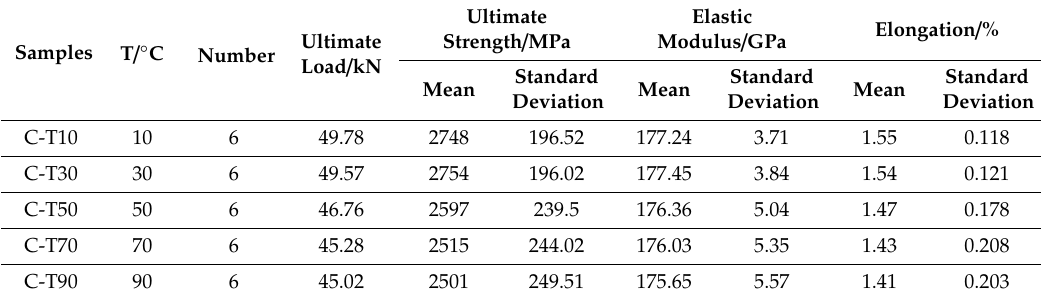
Figure 1. Configuration of Carbon Fiber Reinforced Plastics (CFRP) plate specimens (unit: mm) : ( a ) Schematic diagram; ( b ) Photos. Table 1. The properties of CFRP plate specimens under different temperatures exposure.